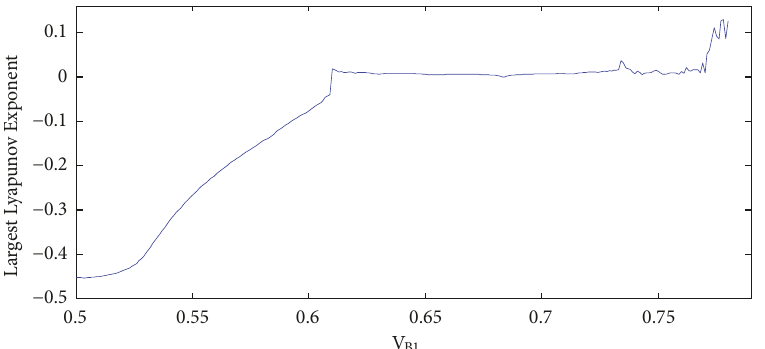
Figure 17: Largest Lyapunov exponent.